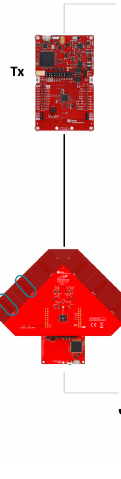
Figure 4 . Experimental